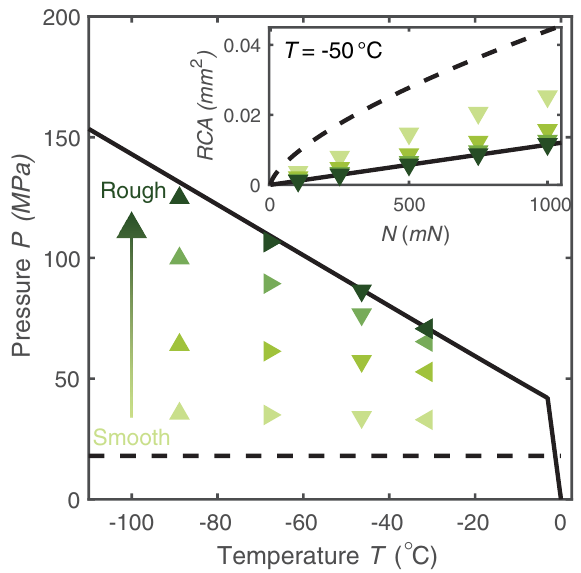
FIG. 8. Pressure P as function of the temperature T for glass spheres with surface roughnesses 98, 222, 575, and 3077 nm at a normal force of 500 mN. The smoothest sphere is mainly elastic where, for increasing surface roughnesses, the pressure increases until the plastic limit is reached. The dashed and solid lines are, respectively, the elastic Hertzian pressure and the penetration hardness P h of the ice. For the latter, the penetration hardness in the normal direction for the set sliding speed of 0 . 38 mm = s is used. Inset: RCA as a function of the normal force N . Indepen- dent of the surface roughness, the real contact area increases linearly with the normal force. Therefore, the contact pressure is almost independent of the normal